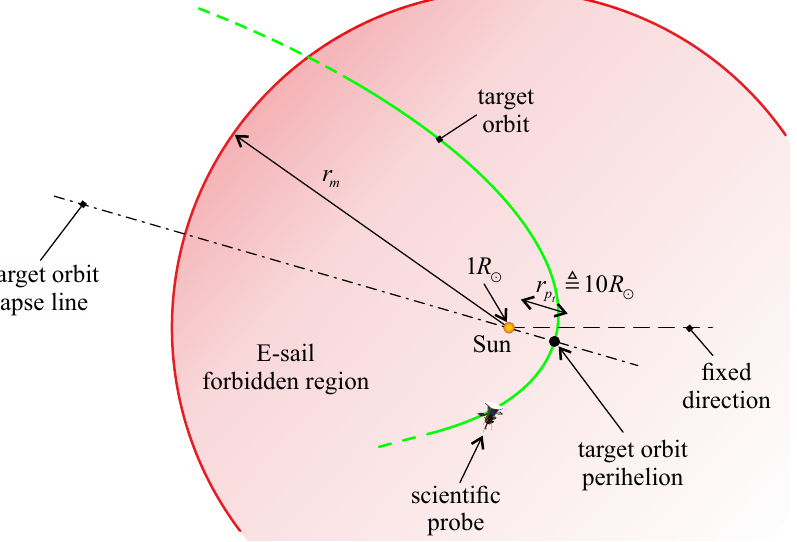
Figure 1. E-sail forbidden region and target orbit perihelion